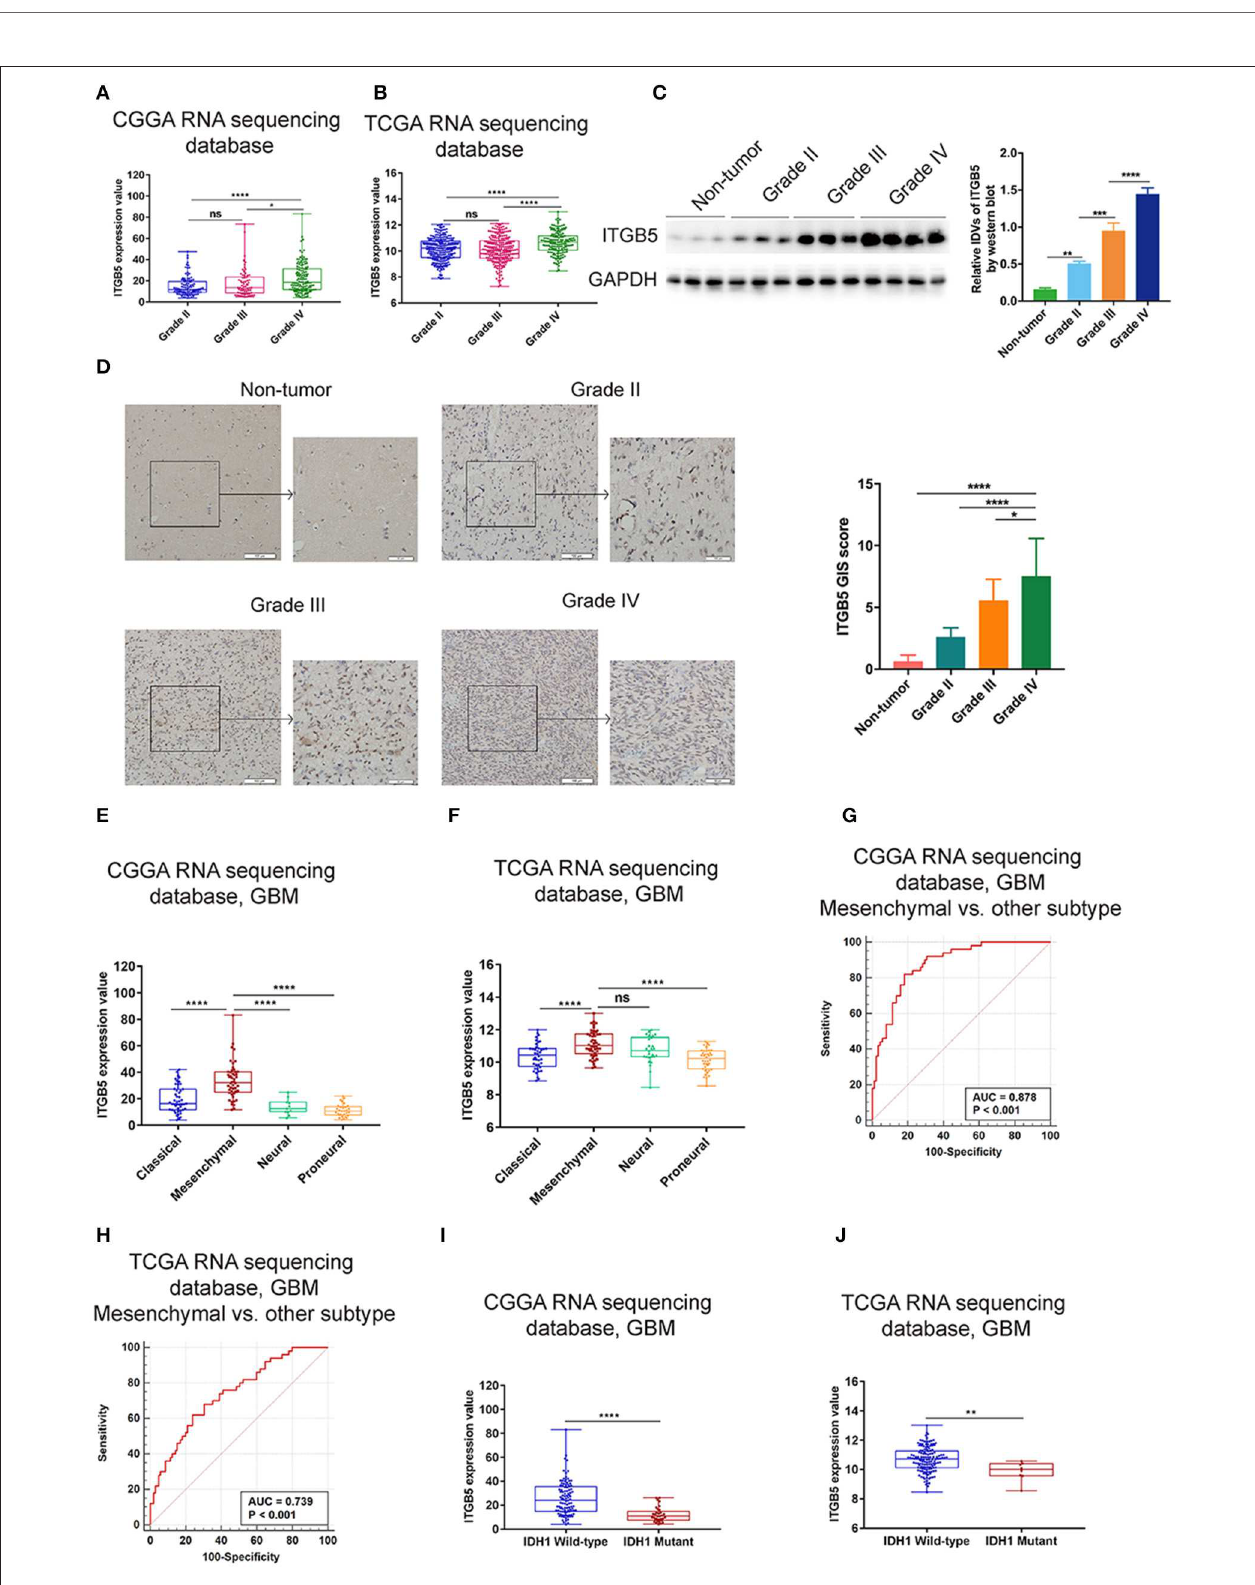
FIGURE 2 | Elevated ITGB5 expression is associated with progressive malignancy and a mesenchymal subtype in glioma. (A,B) ITGB5 expression according to glioma grade ( A , CGGA RNA-seq; B , TCGA RNA-seq). ns, P > 0.05; * P < 0.05; **** P < 0.0001 (one-way analysis of variance [ANOVA]). (C) ITGB5 expression